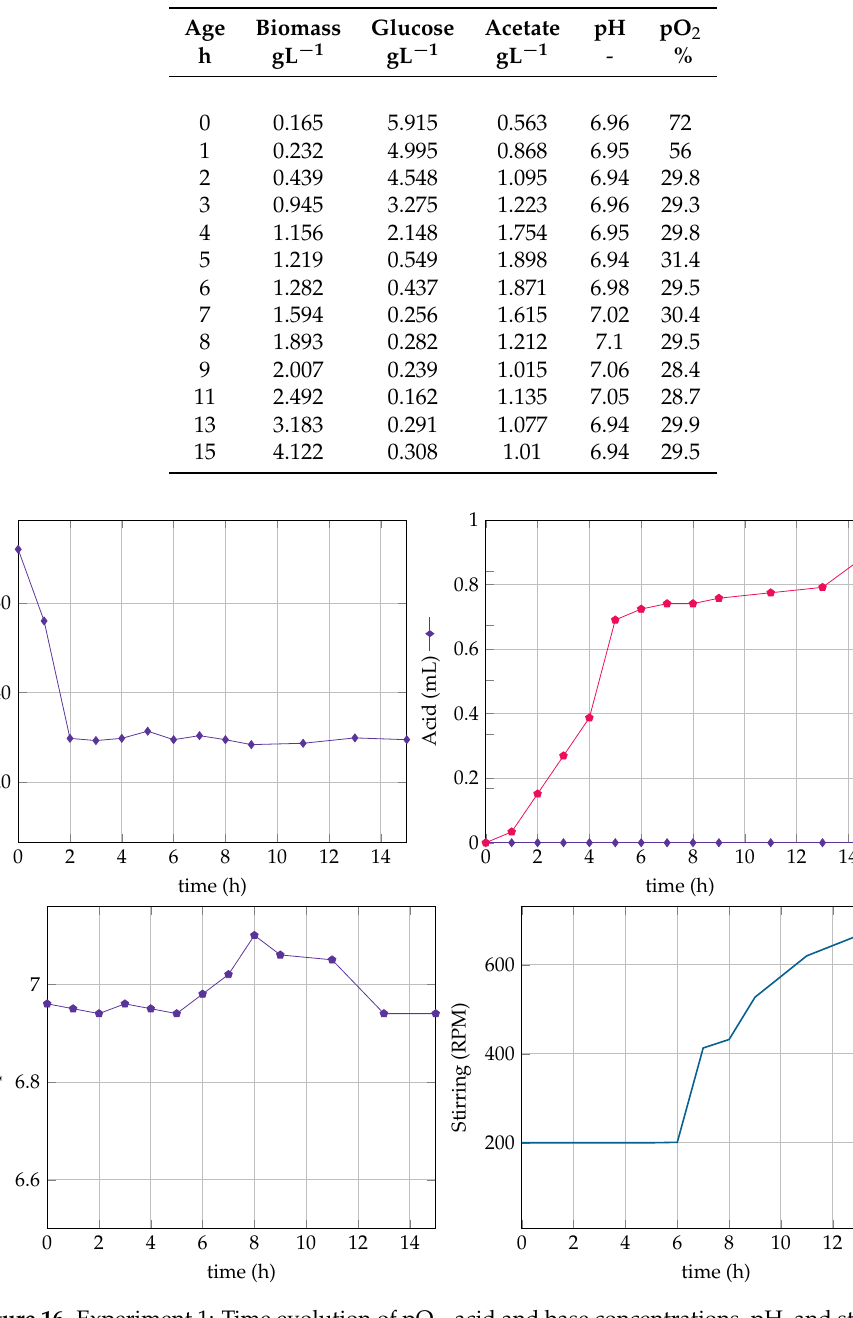
Table 10. Experiment 1: State variables and operating conditions during the culture.